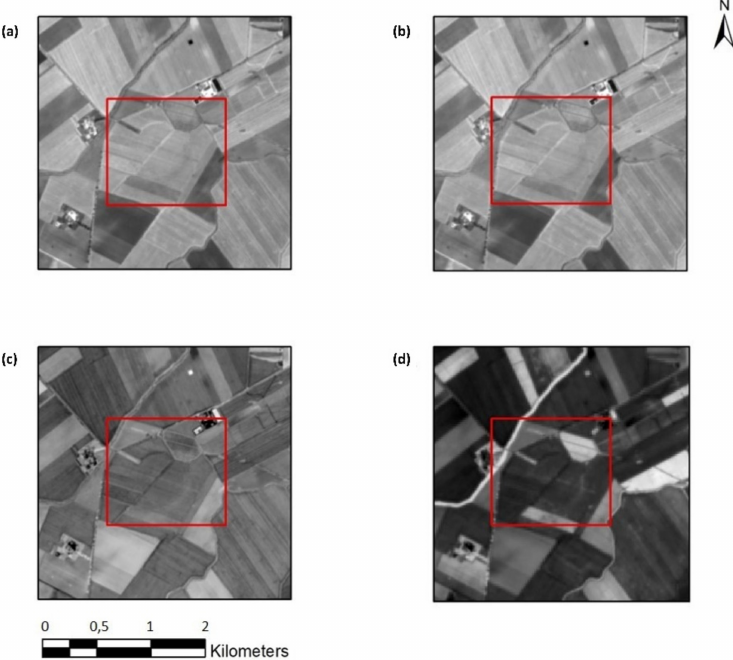
Figure 10. TCT detail of a Neolithic Settlement near Lucera: ( a ) TCT Brightness (2), ( b ) TCT Brightness (5), ( c ) TCT Greenness (3), ( d ) TCT Greenness